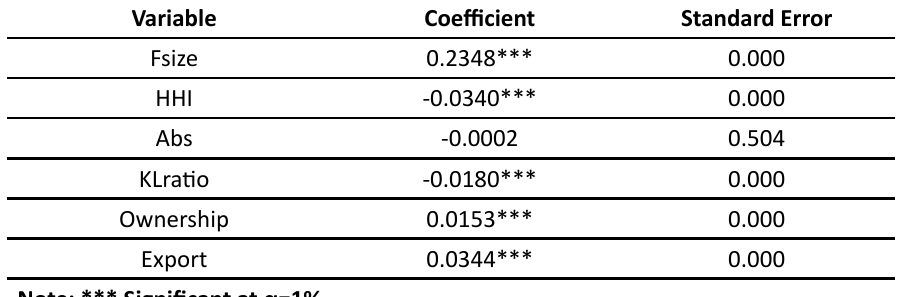
Table 2: The Tobit Regression of the Actual Variable Variable